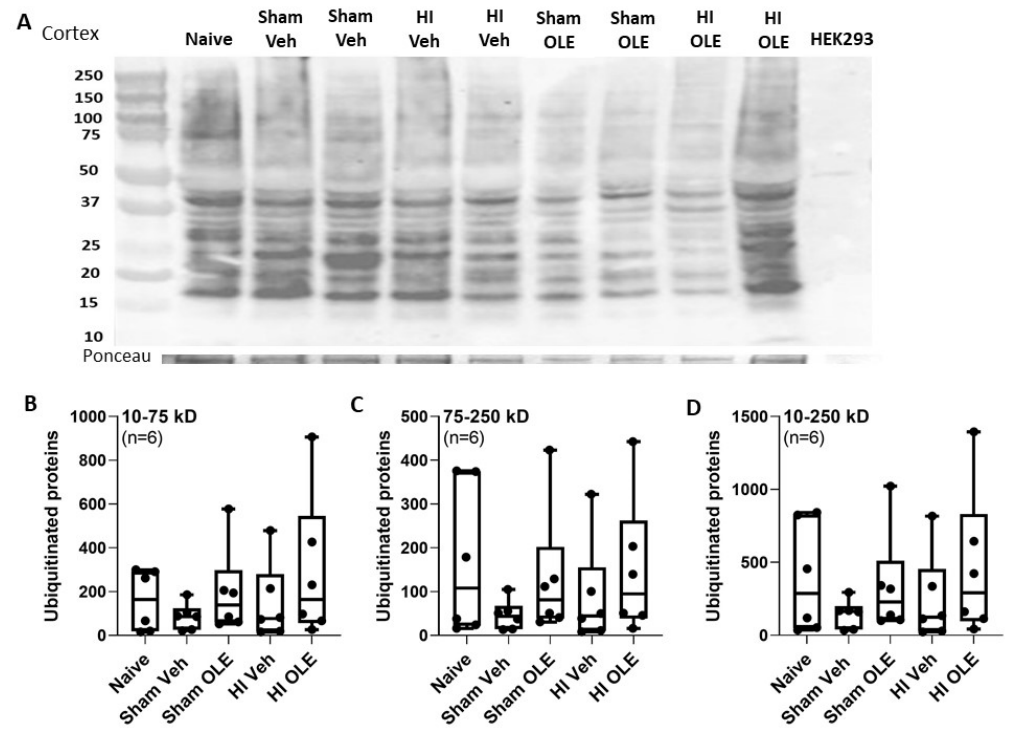
Figure 12. Western blots of ubiquitinated protein immunoreactivity in the somatosensory cortex of piglets that received hypoxia-ischemia (HI) or sham procedure with oleuropein (OLE) or vehicle (veh). ( A ) Full length western blots. ( B – D ) When proteins were analyzed according to molecular weight, the ubiquitinated protein levels did not differ in the 10–75 kD ( p = 0.775), 75–250 kD ( p = 0.485), or 10–250 kD ( p = 0.653) ranges. The box plot whiskers show the 5th and 95th percentiles.